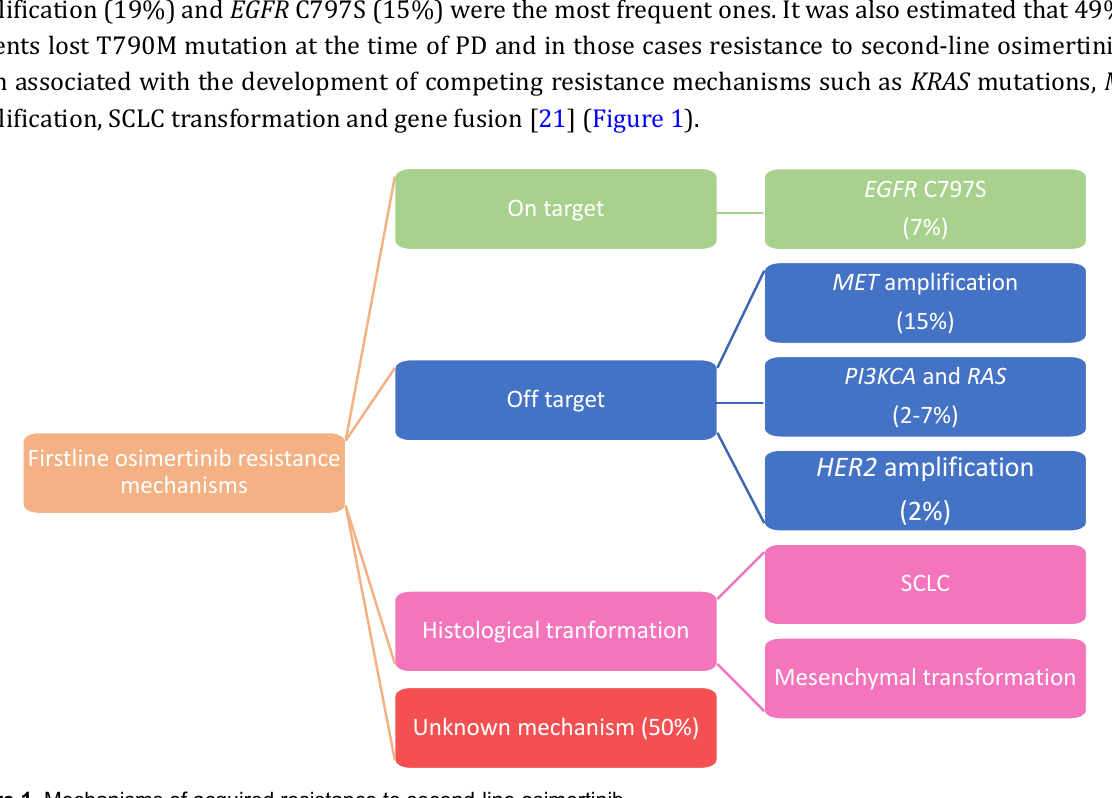
Figure 1. Mechanisms of acquired resistance to second-line